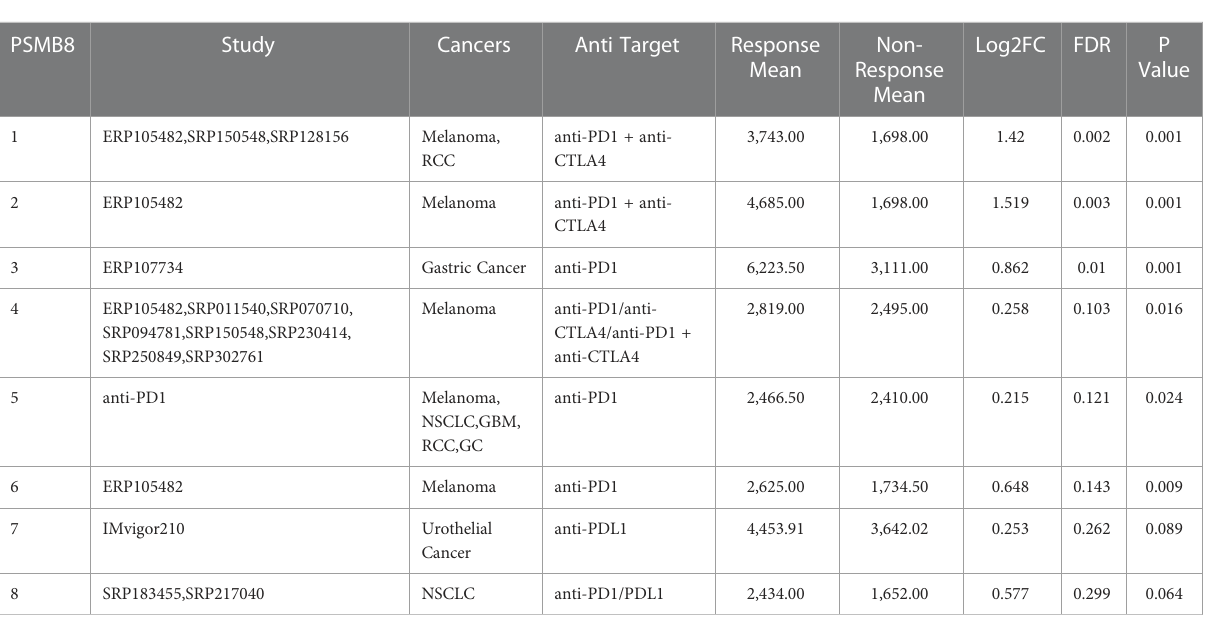
TABLE 1 PSMB8 expression distribution for response and non-response based on pre-treatment samples in all